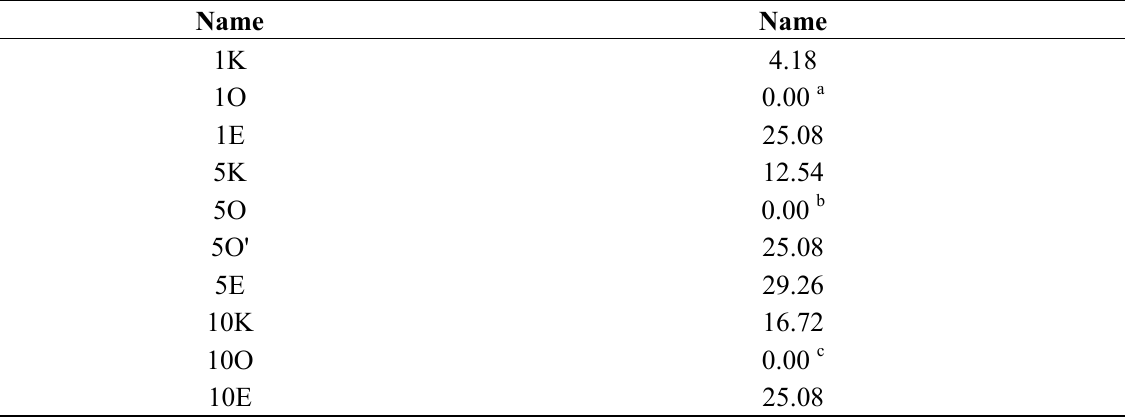
Table 7. MP2 calculated relative energies (kJ mol − 1 ) of different